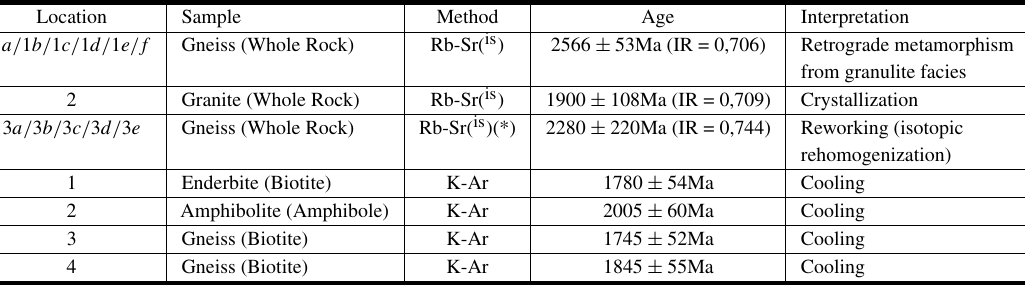
Geochronologic data of the Passa Tempo Metamorphic Complex and respective interpretations [Teixeira 1985 (*) and Fiumari et al. 1985], with location indicated in Figure